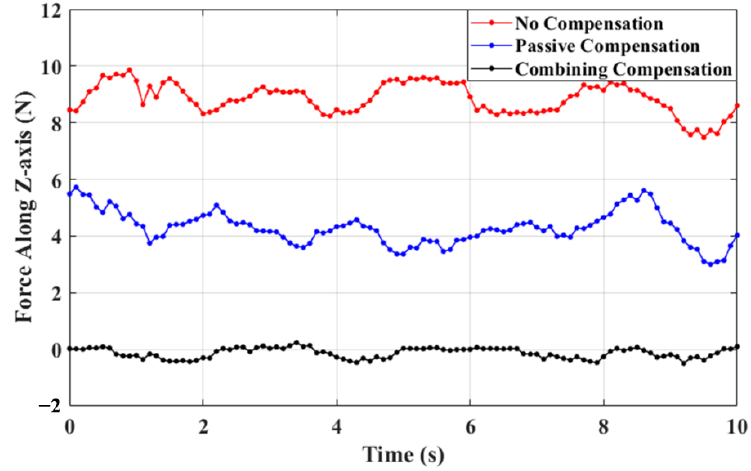
Figure 11. Required forces along the Z -axis with random configurations in the case of no compensation, passive compensation, and combined compensation.